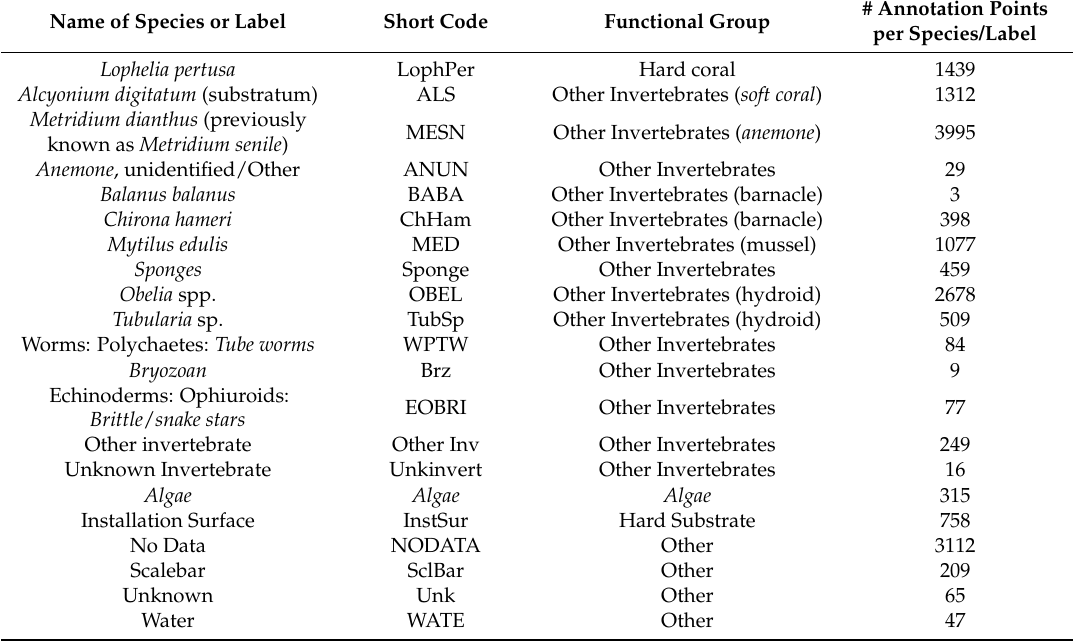
Table 1. Defined project species/label list within CoralNet (used for both classifier and manual analysis). [#: number